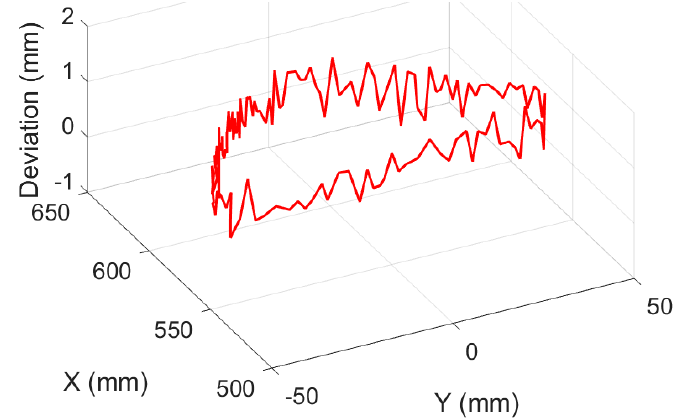
Figure 19. Deviation results of target planning path and actual tool path of experimental deburring for disc of hub.